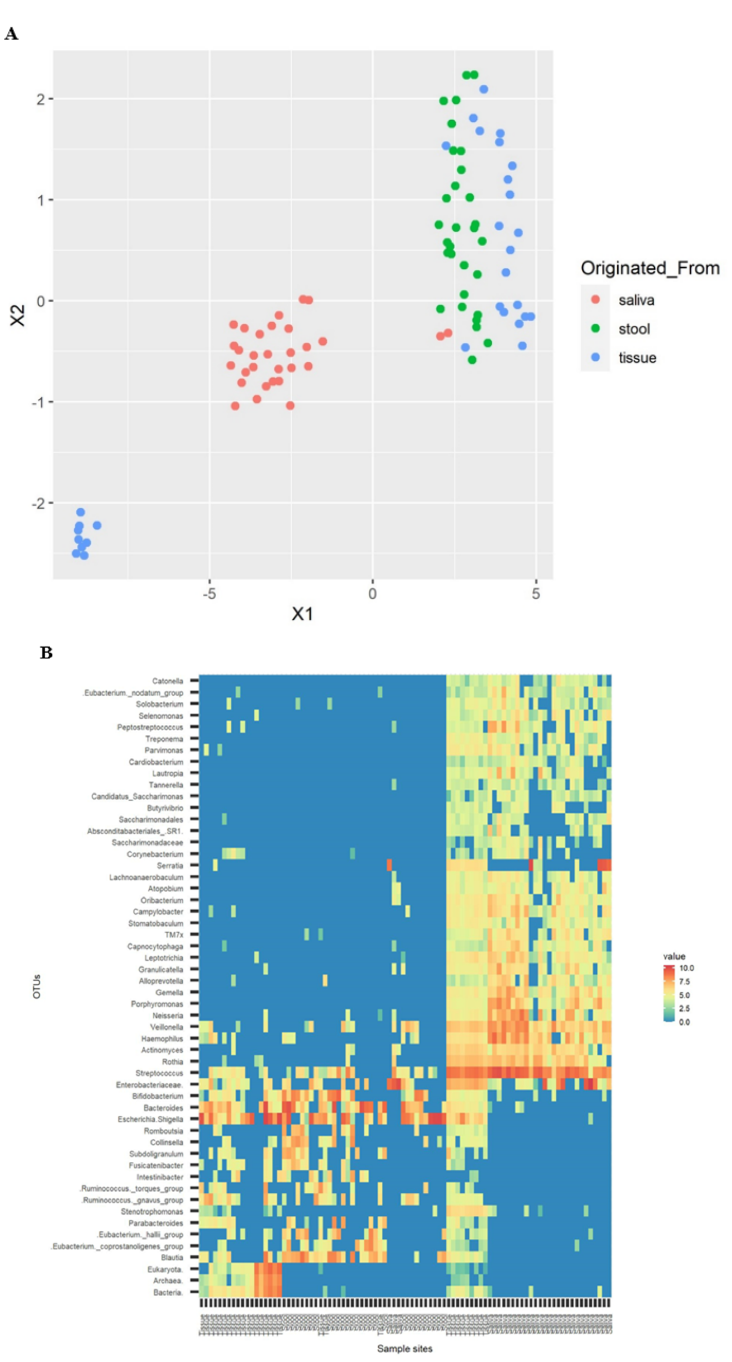
Figure 3. UMAP of the microbiome cluster in the saliva, tissue, and stool samples of patients with CD ( A ). Heatmap of the microbiome cluster in the saliva, tissue, and stool samples of patients with CD ( B ).